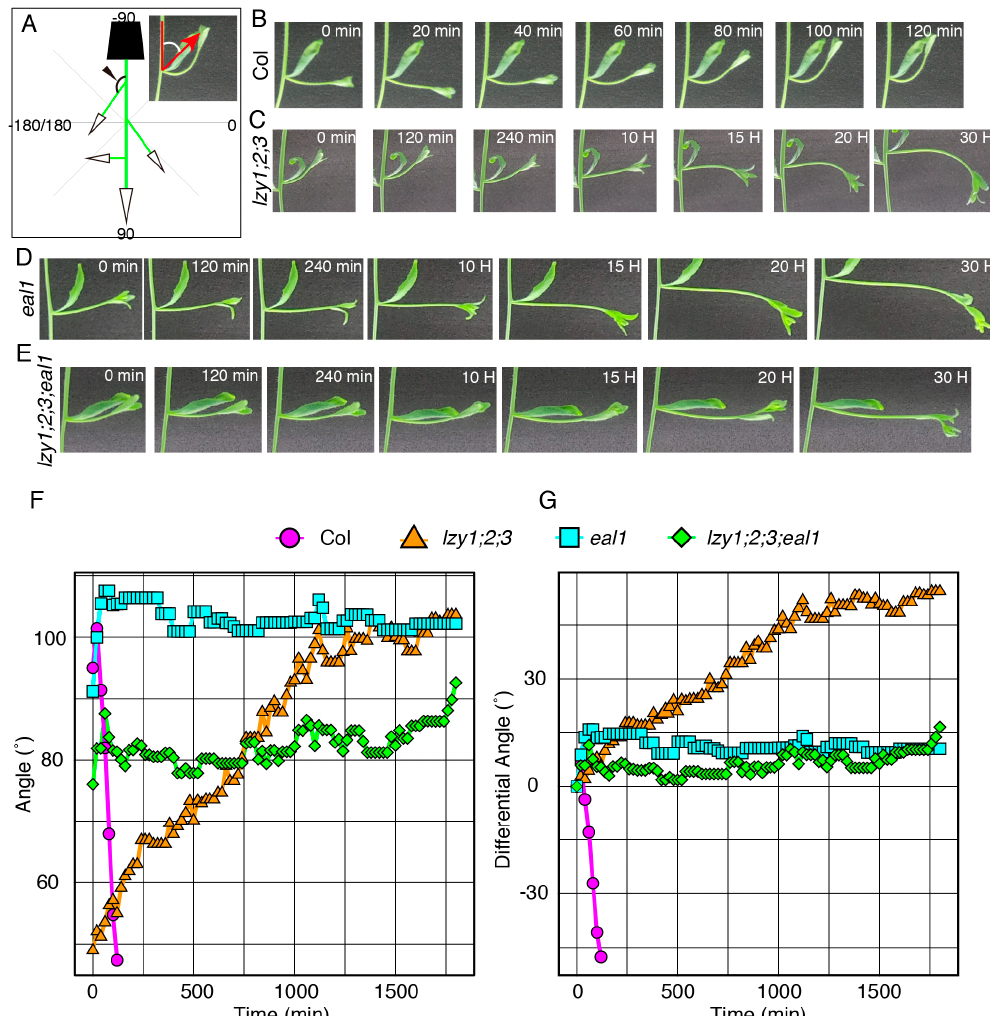
Figure 4. The gravitropic responses of lateral branches. ( A ) Graphical image of the quantification of growth angles of lateral branches. Time-lapse images of lateral branches from wild-type Col ( B ), lzy1;2;3 ( C ), eal1 ( D ), lzy1;2;3;eal1 ( E ) plants after inversion. Immediately after inverting